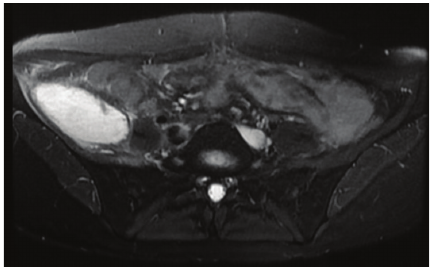
Figure 3: MRI showing axial view of right iliacus muscle sterile seroma.